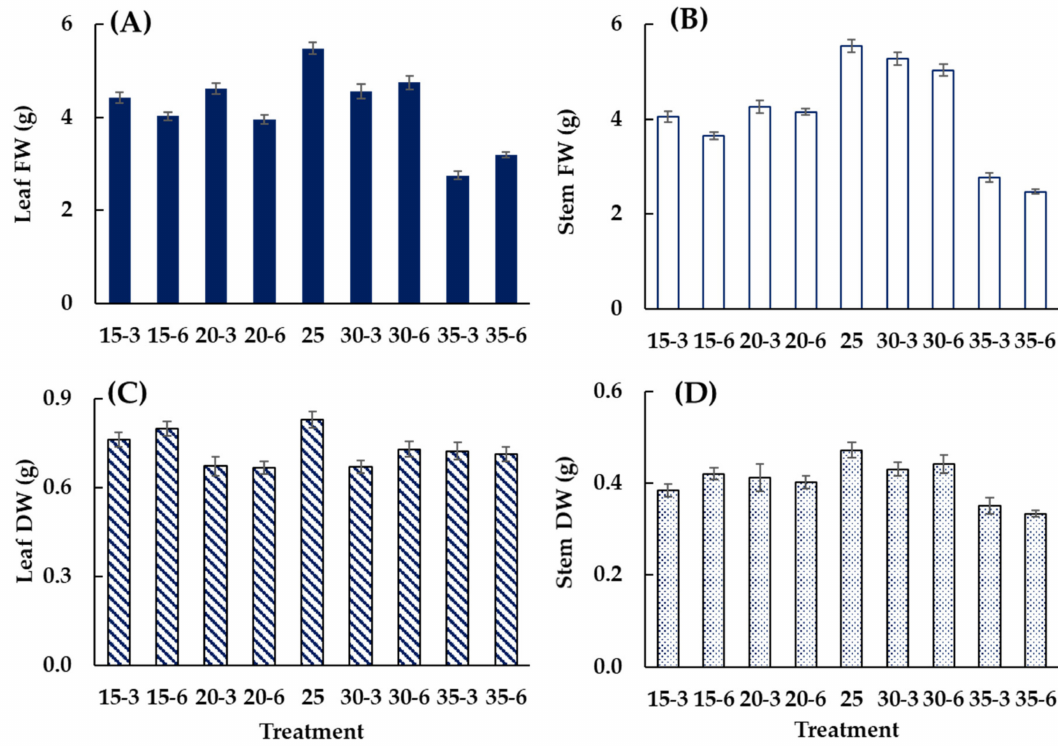
Figure 4. Fresh weight (FW) of leaves ( A ) and stems ( B ), dry weight (DW) of leaves ( C ) and stems ( D ) of corianders on day 18 after transplanting under di ff erent root-zone temperatures and stress periods. Data are shown as mean ± SE, n = 16.